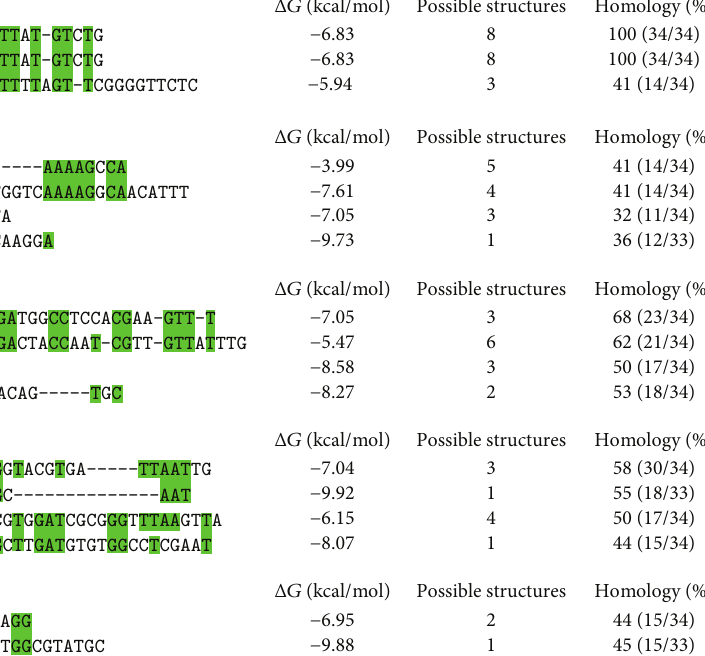
Figure 4: Sequence families of the round 12 library. Only the variable region is shown in the aligned subfamily of the CTAA superfamily. MRE sequences are aligned to the CTAA tetranucleotide sequence. Highlighted regions represent sequence homology shared in the subfamilies. Δ𝐺 represents the Gibbs free energy values. Possible structures indicate the number of predicted structures from the Mfold web server [33]. Percent homology is calculated from highlighted nucleotides divided by the length of the sequenced variable region.